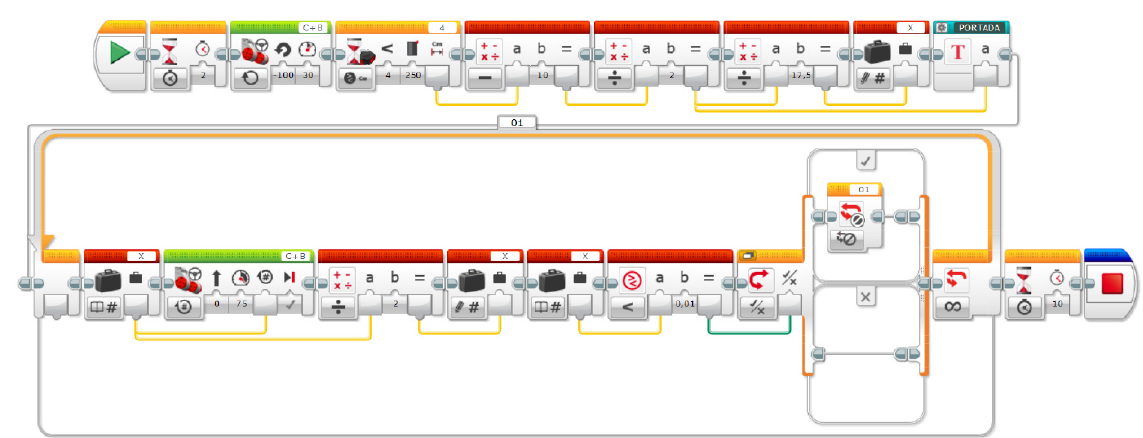
Figure 7. Program for the physical visualization of the convergence of Cauchy’s